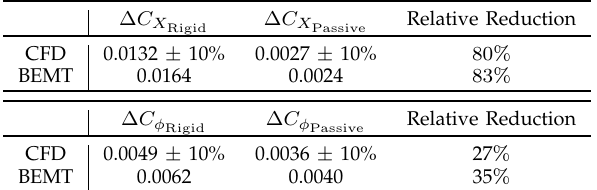
TABLE II: Thrust ( ∆ C X ) and tangential force ( ∆ C ϕ ) amplitude of rigid and passive pitch blade predicted by CFD and